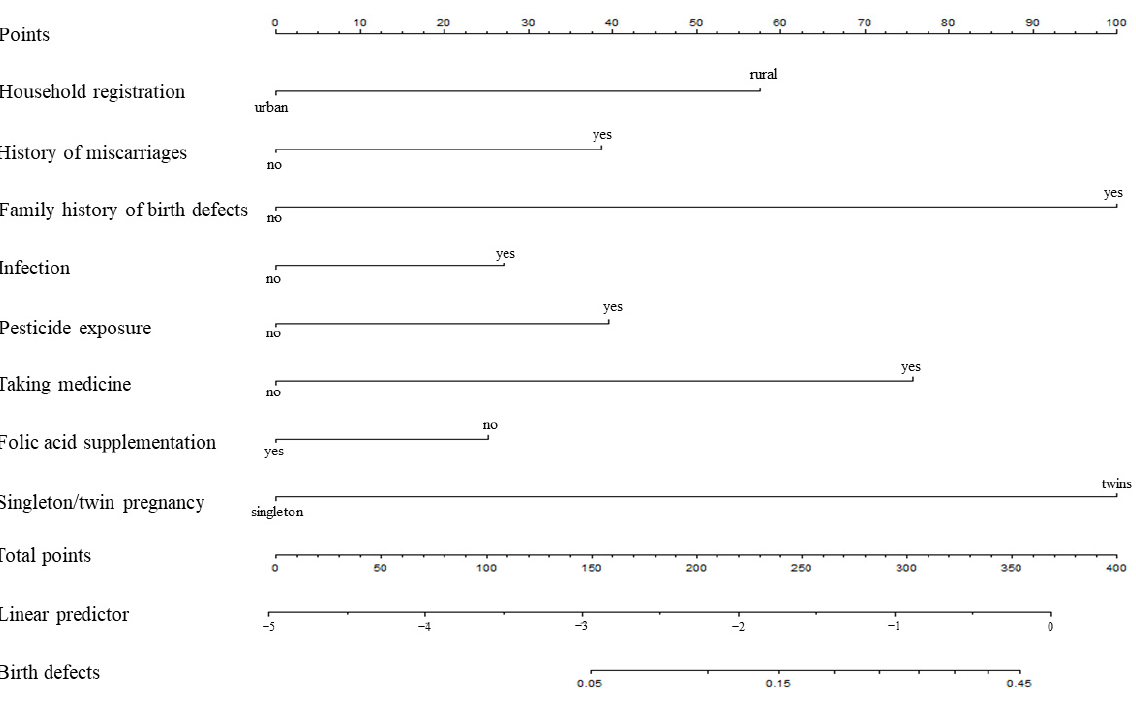
Figure 1. Nomogram for predicting birth defects.